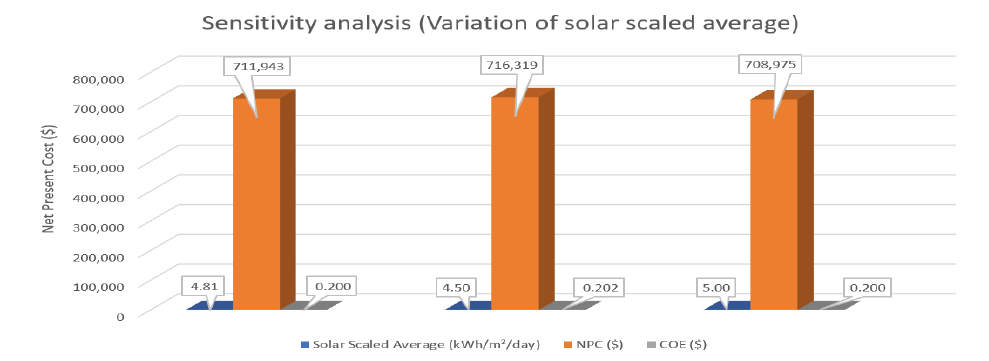
Figure 14. Variation of Solar